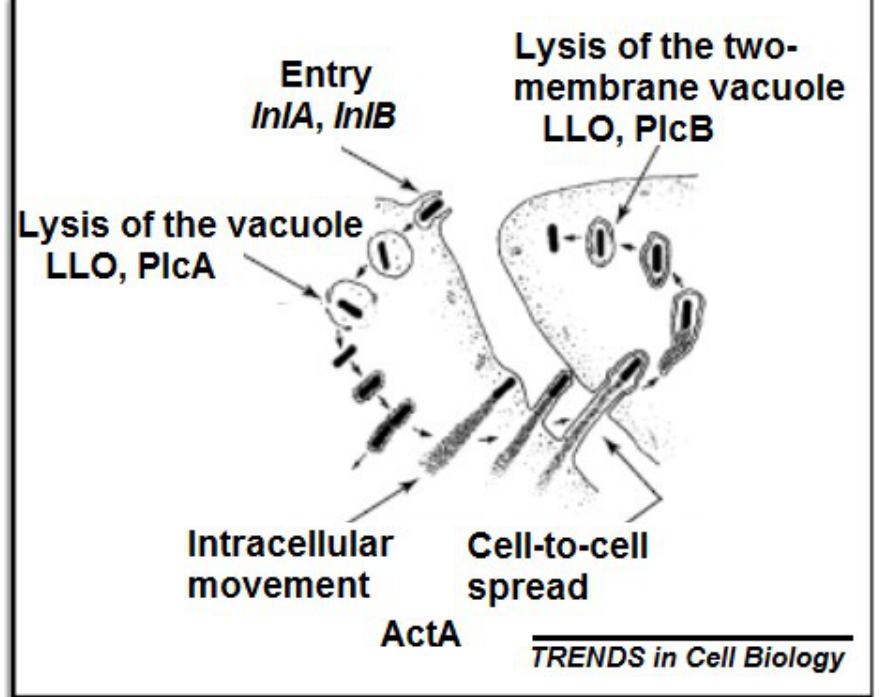
Figure 1. Infection process of a host cell by L. monocytogenes [71].